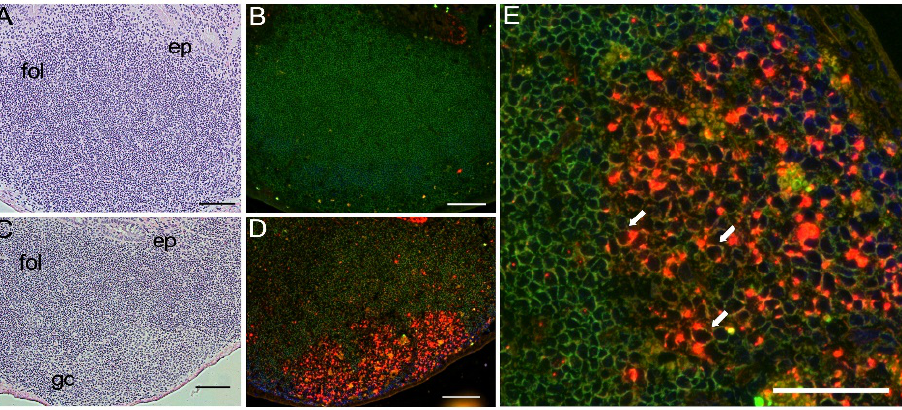
Figure 4. Immunohistochemical detection of FLAG-tagged mA3 protein in Payer’s patches. Frozen tissue sections prepared from WT B6 ( A , B ) and homozygous FLAG KI mice ( C – E ) were stained with HE (panels ( A , C )) or with fluorescent Ab specific for B220 (green) and FLAG (red) (panels ( B , D , E )). Panels ( A , B ) and ( C , D ) respectively show corresponding view fields from serial sections. Bars indicate 100 µ m in panels ( A – D ), and 50 µ m in ( E ). In panels ( A , C ), “ep” indicates epithelial cells, “fol” a follicle, and “gc” a germinal center within a follicle. Note that the B-cell follicle in WT B6 mouse is negative for FLAG-tagged mA3. In panels ( D , E ) cells in follicles and GC show an orange color, indicating that these B cells are positive for both B220 and FLAG. Higher magnification in panel ( E ) shows the cytoplasmic location of FLAG-tagged mA3 in B220 + large B cells sparing nuclei (arrows). Immunohistochemical staining was performed a total of 4 times with a few specimens for each genetic group in each experiment with results essentially identical to those shown above.